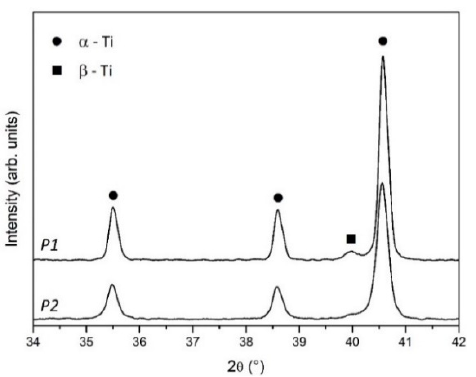
Figure 3. XRD patterns of P1 and P2 powders. Full dot— α -Ti, full square— β -Ti.